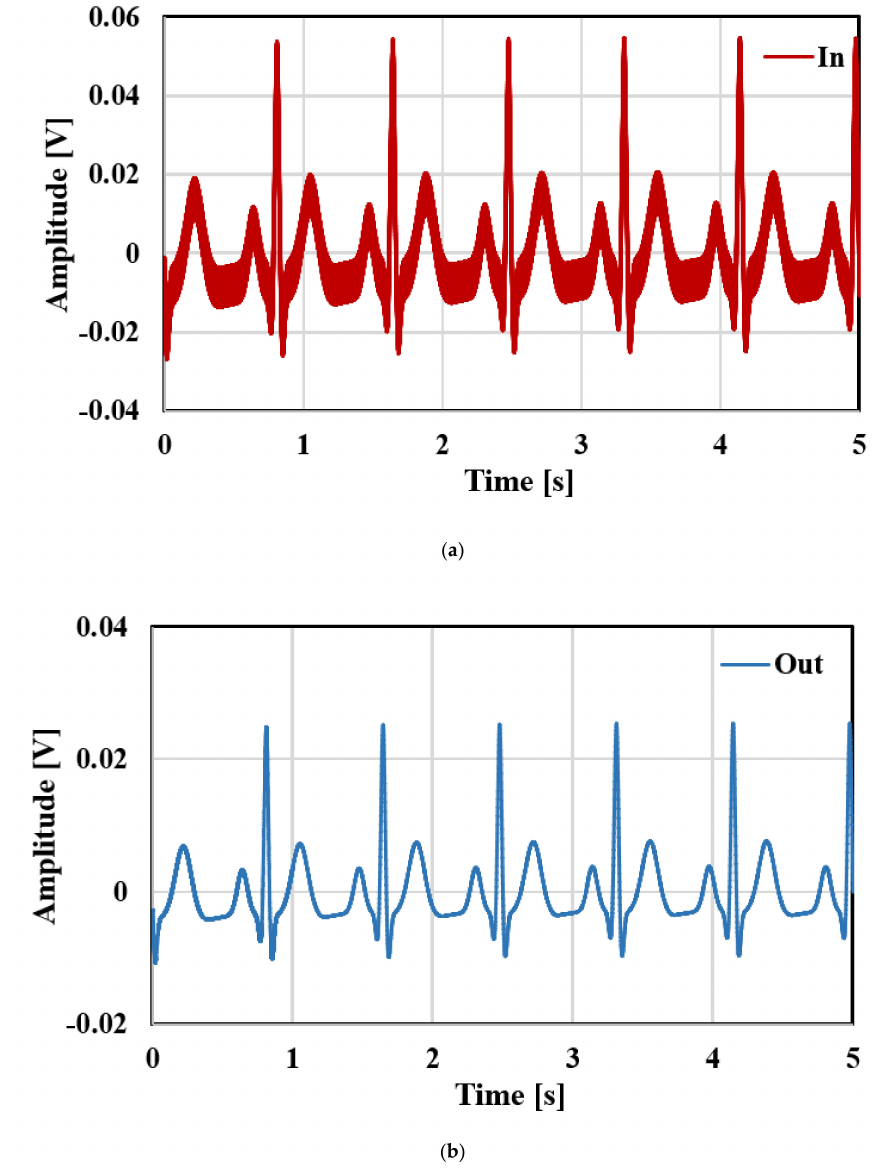
Figure 18. Transient response of the filter for ECG signal: ( a ) input; ( b )